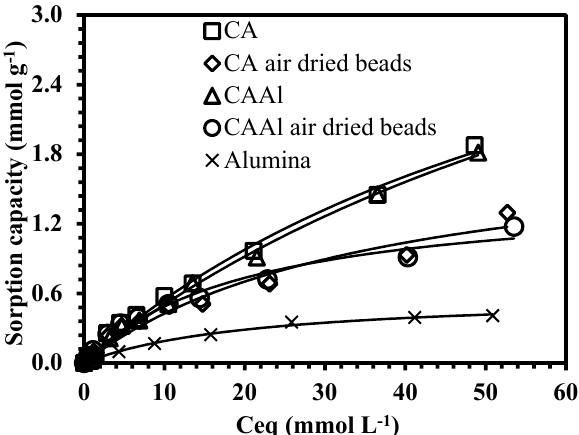
Figure 4. Equilibrium studies. ( a ) Boron sorption isotherms using hydrogel and air-dried beads. ( b ) Sorption isotherms using different types of alginates (pH 0 :11, equilibrium pH: 9.5–9.8, V = 100 mL, T room, 1 atm). Table 1. Langmuir and Freundlich parameters of the sorbents for boron removal. Experimental Langmuir